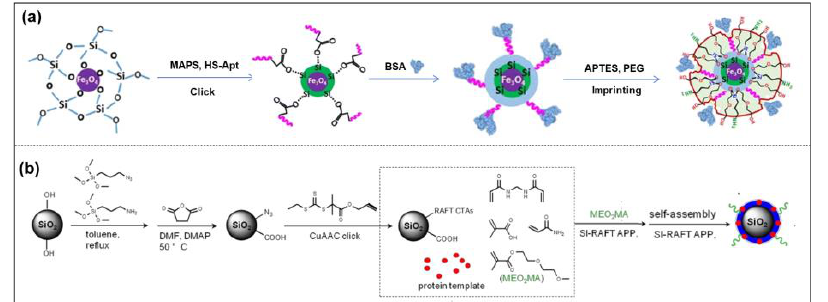
printed with permission from Ref. [64,66]. Copyright 2018, Springer; 2019, Royal soc of